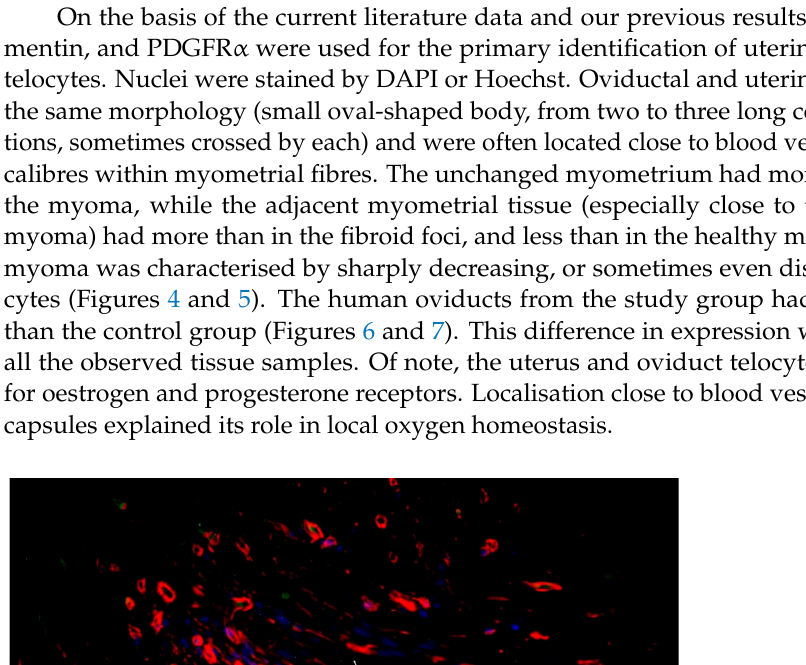
Figure 3. Samples of human oviduct stained for NOS (green, Alexa Fluor 488) in the control ( A ) and study ( B ) groups. Total magnification: ×200.